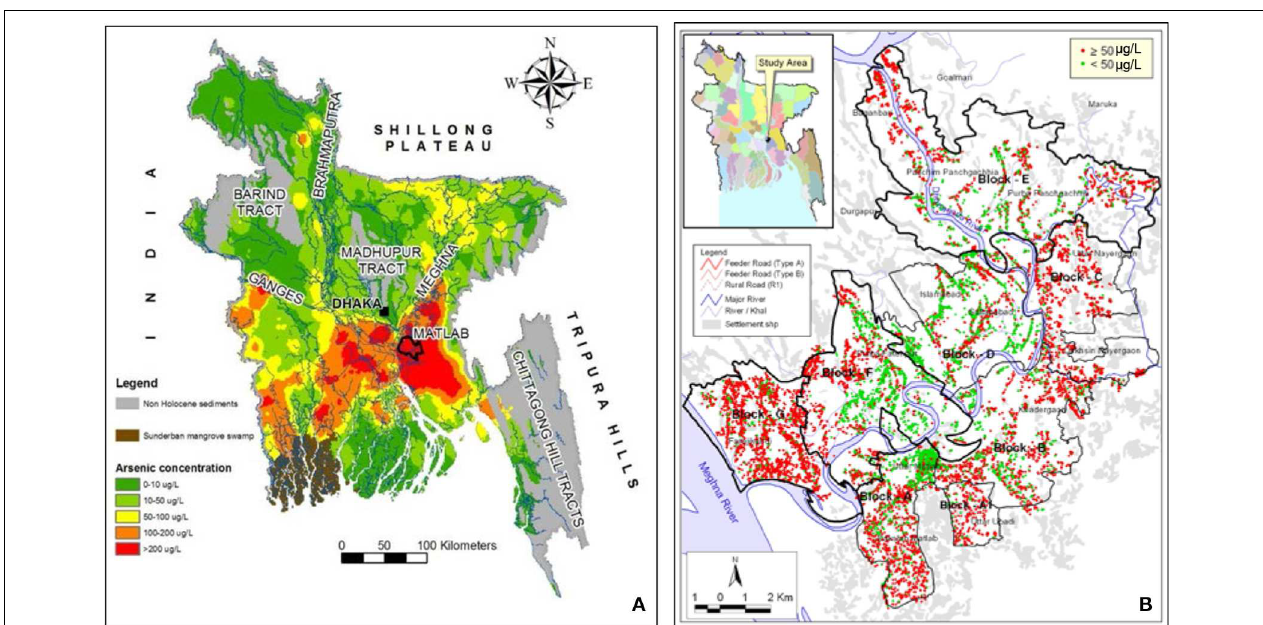
FIGURE 1 | (A) Matlab region in Bangladesh map and (B) the study area showing green dots for the tubewells with As concentrations < 50 µ g/L and red dots for those with ≥ 50 µ g/L (modified from Jakariya et al., 2007).